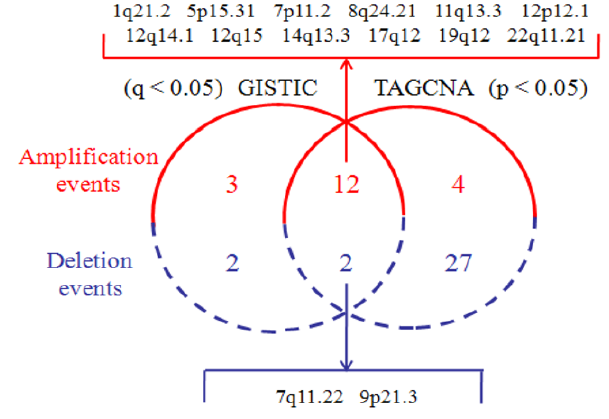
Figure 5. A Venn diagram comparison between GISTIC and TAGCNA in terms of SCEs identified in the lung adenocarcino- ma data. The overlapped amplification and deletion events are listed in the top and bottom of the Venn diagram. Here, we use the common cutoffs q , 0.05 and p , 0.05 for GISTIC and TAGCNA, respectively.